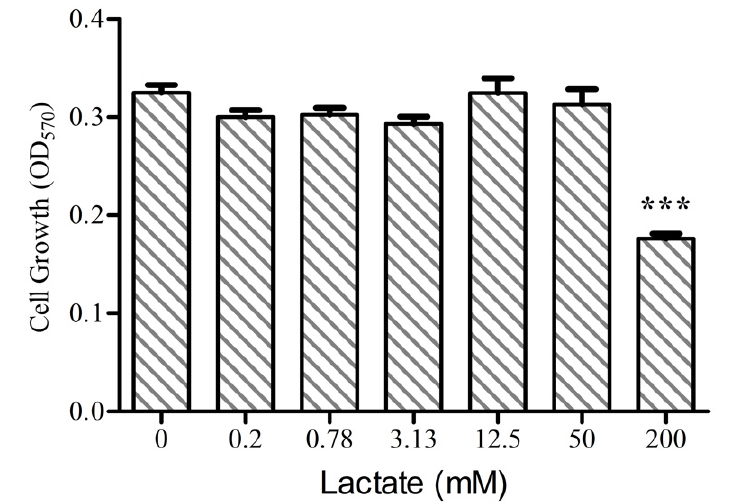
Figure 1. Determination of the cytotoxic activity of lactate on Caco-2 Cells using the MTT assay. N = 4, values are means ± SEM, *** p < 0.0001.